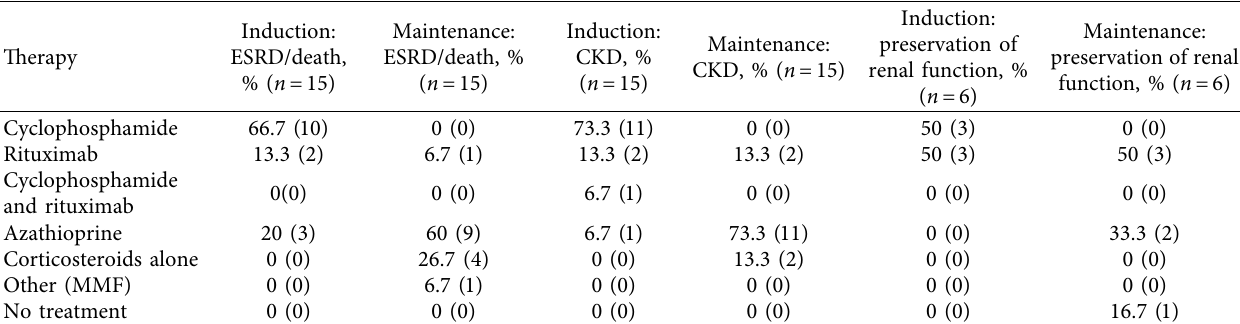
Table 4: Summary of induction and maintenance treatment: breakdown of patients with ESRD or death, CKD, and preservation of renal function.